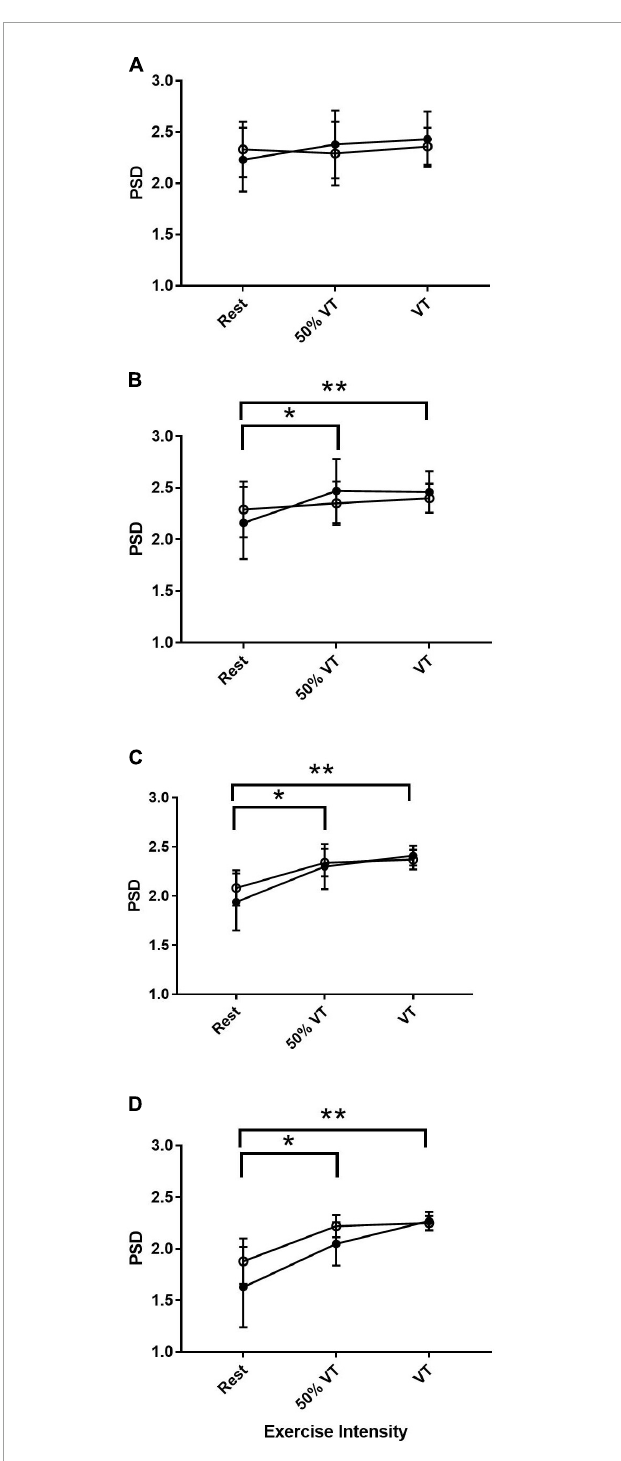
FIGURE2 Power spectral density (PSD) responses in alpha slow (A) , alpha fast (B) , beta (C) , and gamma (D) within the motor cortex in AH ( • ) and MI ( ◦ ). Significant differences between rest and intensities; * P < 0.05, ** P < 0.01.